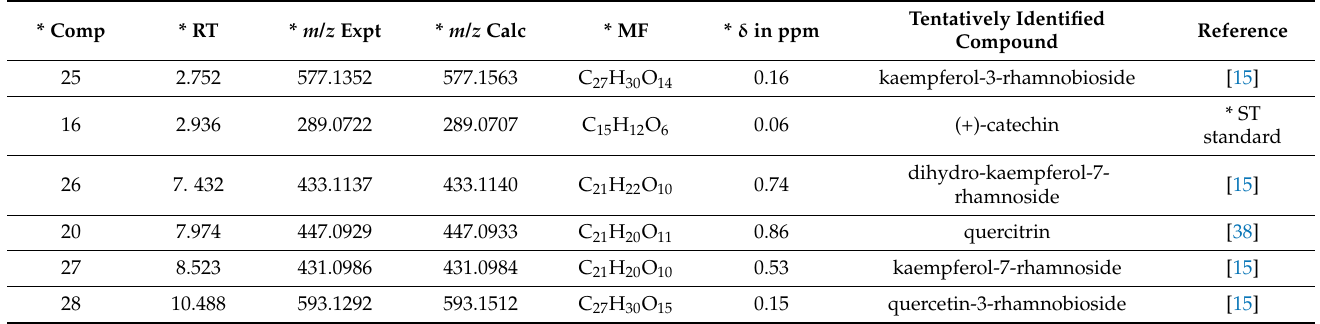
Table 5. Tentative assignment of compounds in Exocarpos cupressiformis leaves (crude